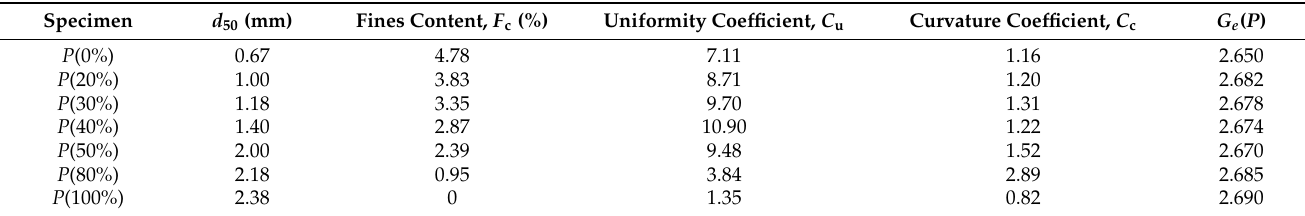
Table 1. Physical properties of soils used by Ham et al. (2010)